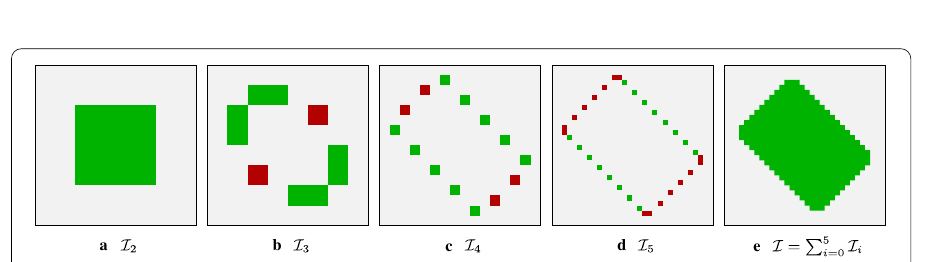
Fig. 19 Creating the resulting image I , on which the compression techniques can be applied. The current figure is based on the example depicted in Fig. 18 and on the procedure illustrated by the flowchart in Fig. 17. In the current case, all images have a resolution of 2 5 × 2 5 of pixels, meaning, that in I 5 the single